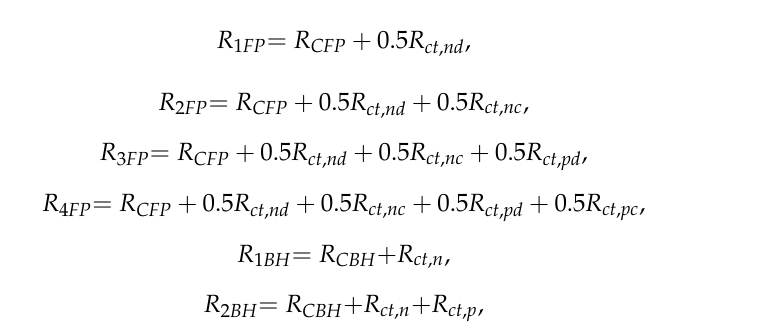
ct , pc ; ( b ) R ct , pd ; ( c ) R ct , nc ; and ( d ) R ct , nd